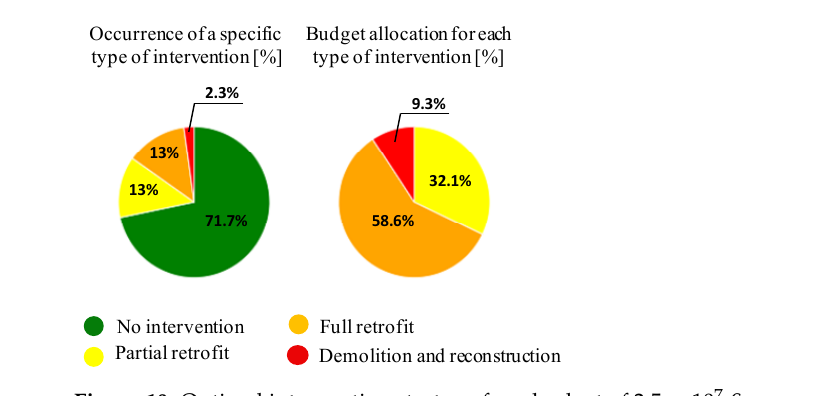
Figure 10. Optimal intervention strategy for a budget of 2.5 × 10 7 €.